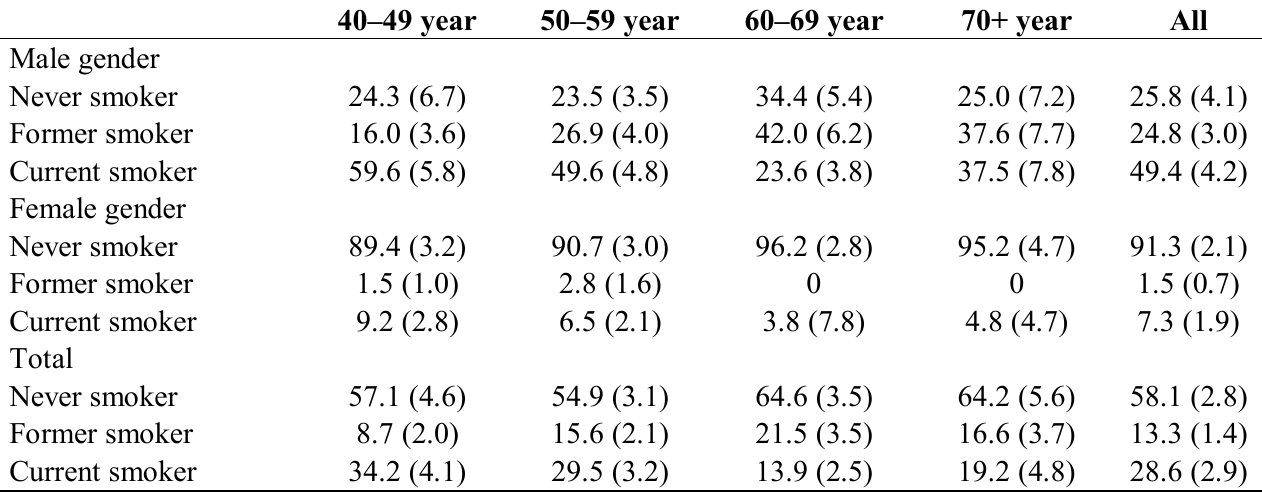
Table 2. Population estimates of the smoking distribution in Sousse, Tunisia, by age and gender * .